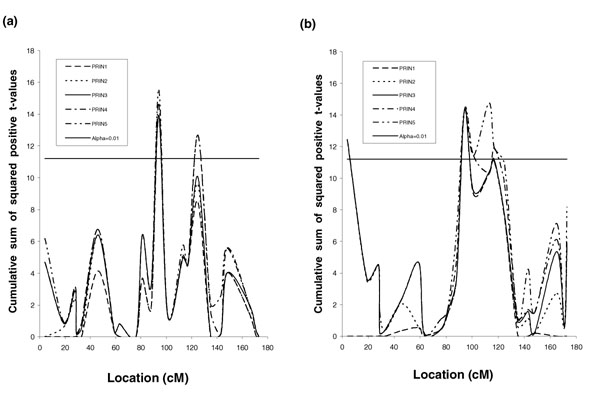
Cumulative t2 statistics for five principal components (PRIN1-PRIN5) of two longitudinal phenotypes Each line depicts the sum of t2 values (for t > 0) for all of principal components up to and including the ith for systolic blood pressure (a) and hypertension (b).